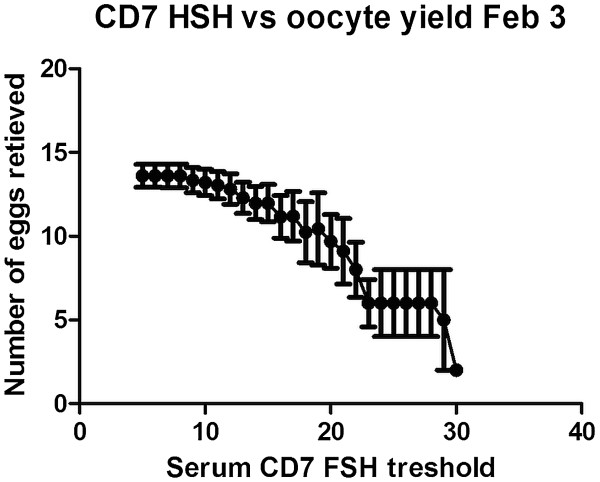
CD7 FSH and oocyte yield. Oocyte yields with different thresholds of serum FSH on CD7 to define a high level starting with a threshold of > 5 IU/L until 30 IU/L. Error bars indicate the standard error of the mean.